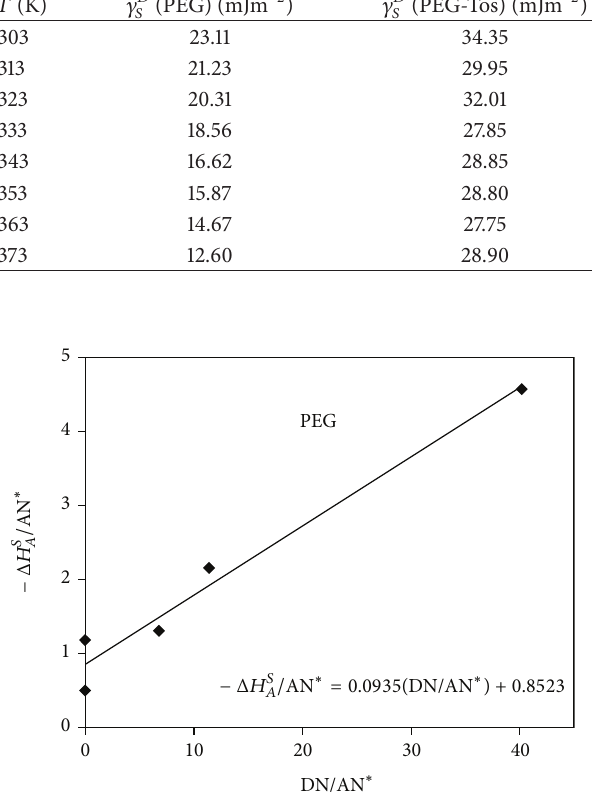
Figure 7: The plot of −Δ𝐻 𝑆 𝐴 / AN ∗ versus DN / AN ∗ for PEG.